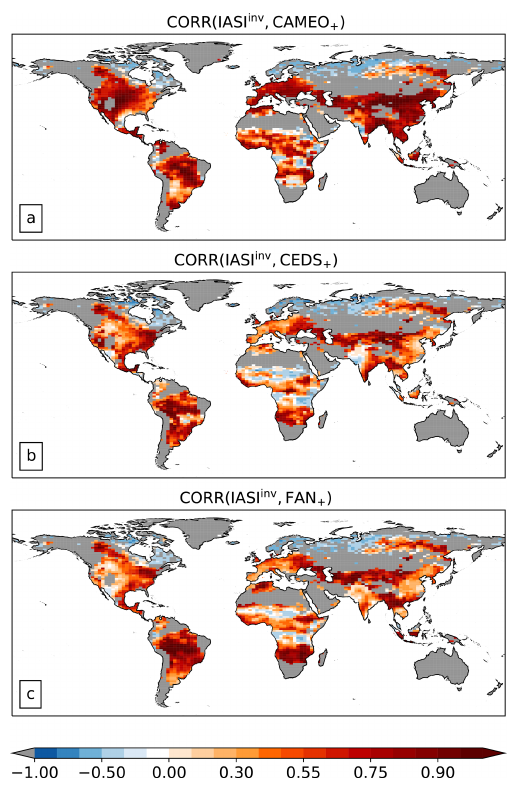
Figure 13. Temporal correlation scores between IASI inv and CAMEO emissions aggregated with other sources (a) and between IASI inv and total emissions from CEDS for agricultural, industrial, and waste sources aggregated with biomass burning (b) over the 2011–2015 period. Temporal correlation scores between IASI inv and FANv2 aggregated with other sources are shown in panel (c) . Other sources include biomass burning from van der Werf et al. (2010) and industrial and waste sectors from CEDS. Gray grid cells correspond to a standard deviation in the monthly IASI inv time se- ries lower than 0.2gNm − 2 yr − 1 in order to avoid biased correlation